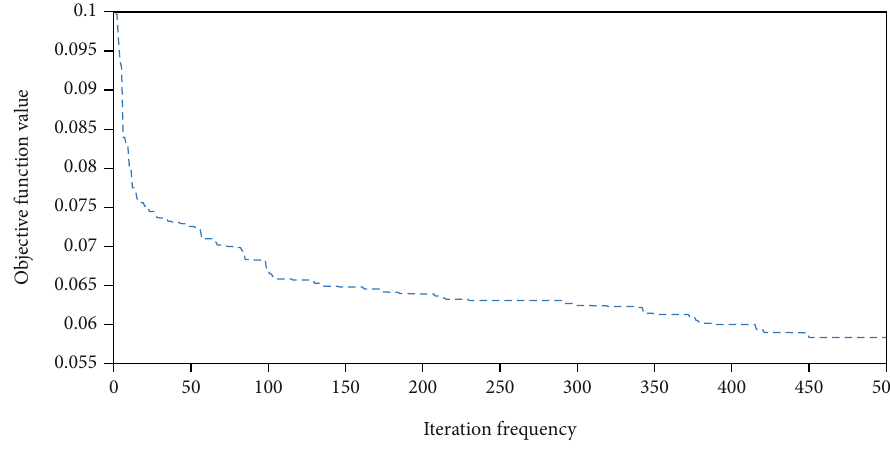
Figure 4: Fitness running process